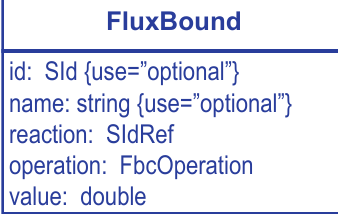
Consistency of flux